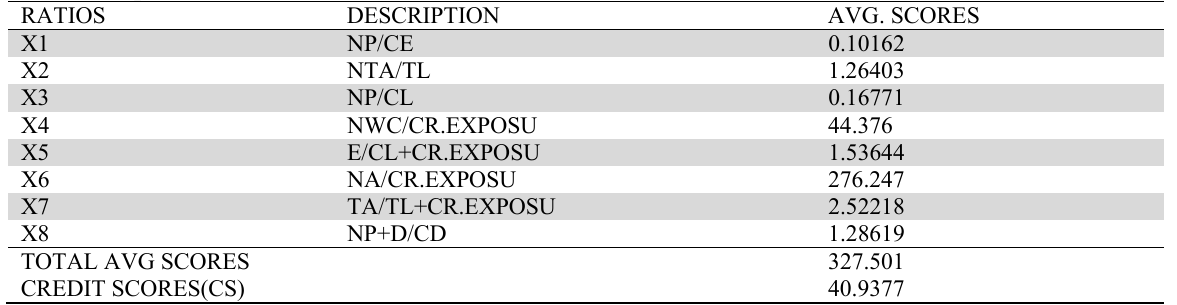
Risk description model-Ratio measurement (Beta)